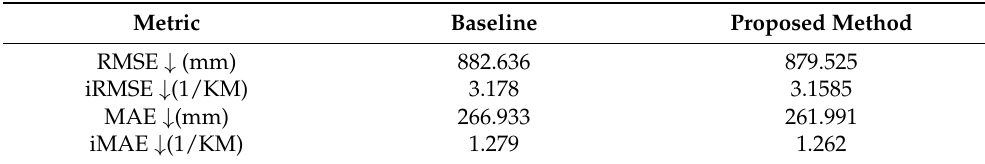
Figure 14. Validation MAE for each epoch for both the proposed method and the baseline. Table 3. Evaluation metrics for the last trained epoch using the validation dataset where ↓ indicates that the lower the value is the better).